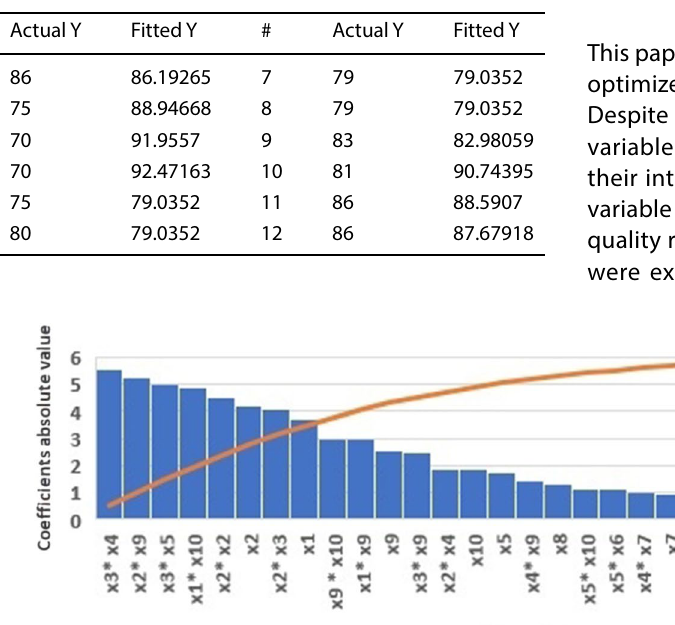
Table 14 Testing the model for the second interval